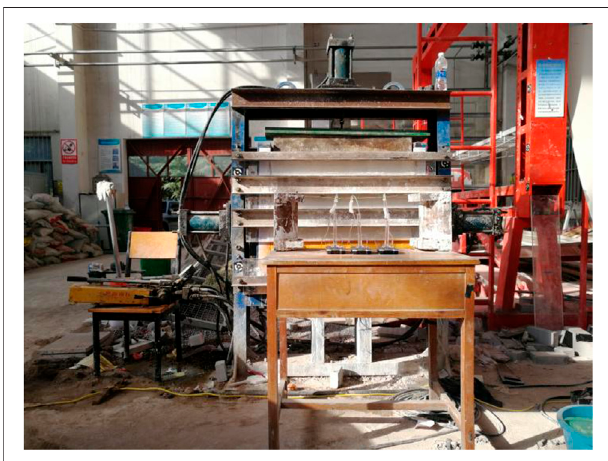
FIGURE 2 | Borehole deformation similarity simulation test